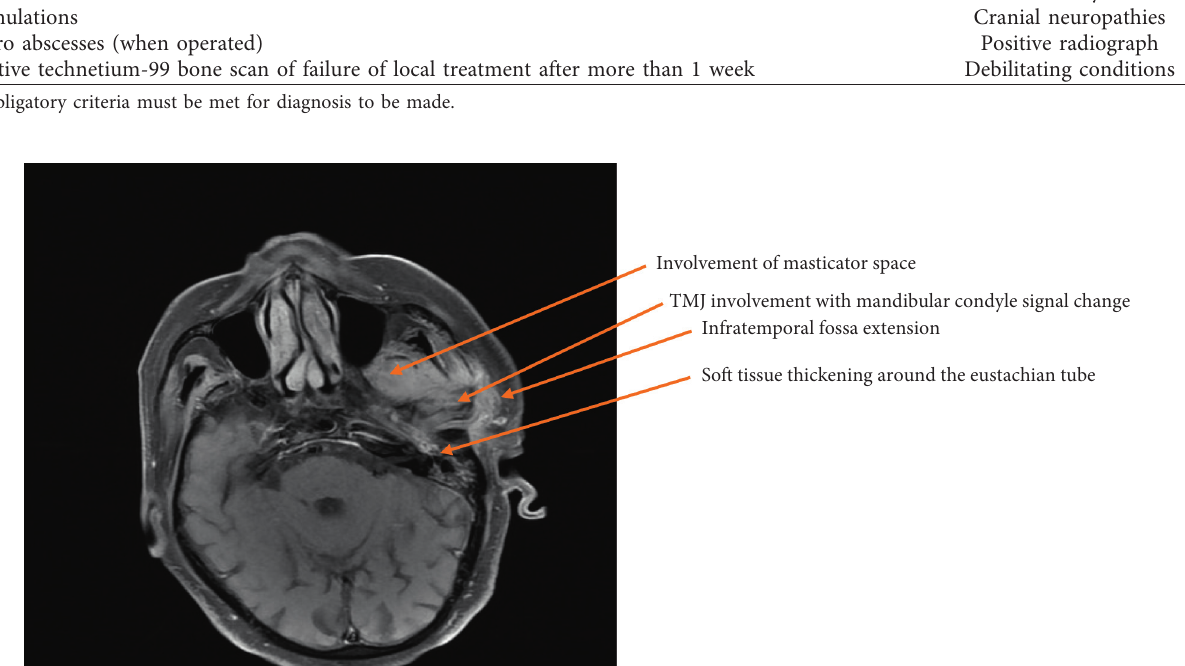
Figure 1: T1-weighted axial section MRI demonstrating left-sided necrotising otitis externa involving the left temporomandibular joint before treatment.